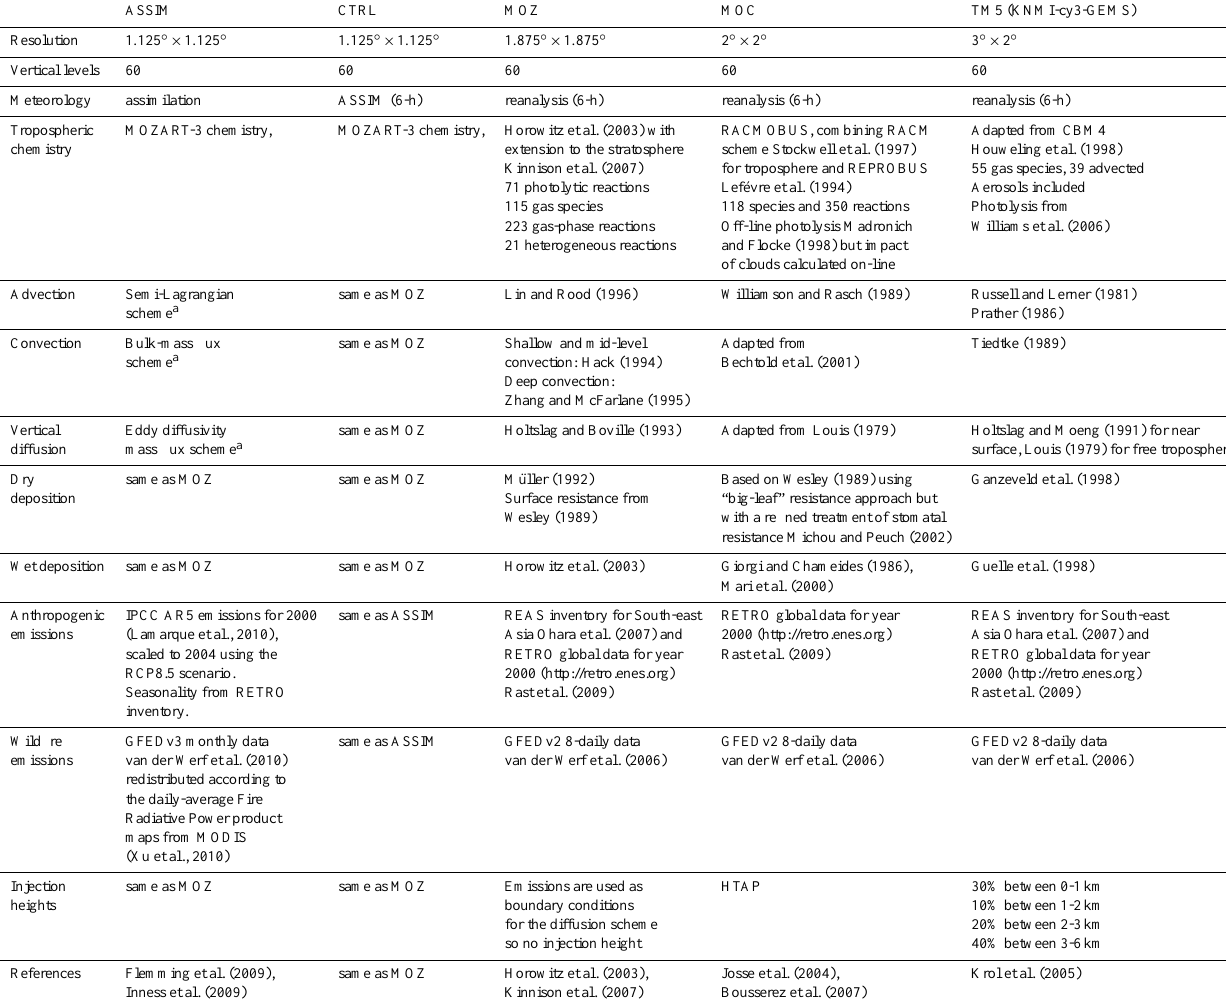
Table 1. Brief description of models. a As described at http://www.ecmwf.int/research/ifsdocs/CY31r1/index.html.